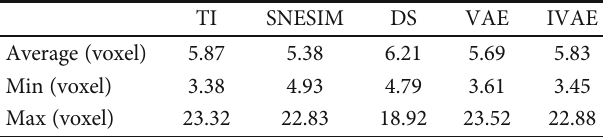
Table 6: The maximum, minimum ,and average pore diameters in the TI and the reconstructions of IVAE, SNESIM, VAE, and DS.